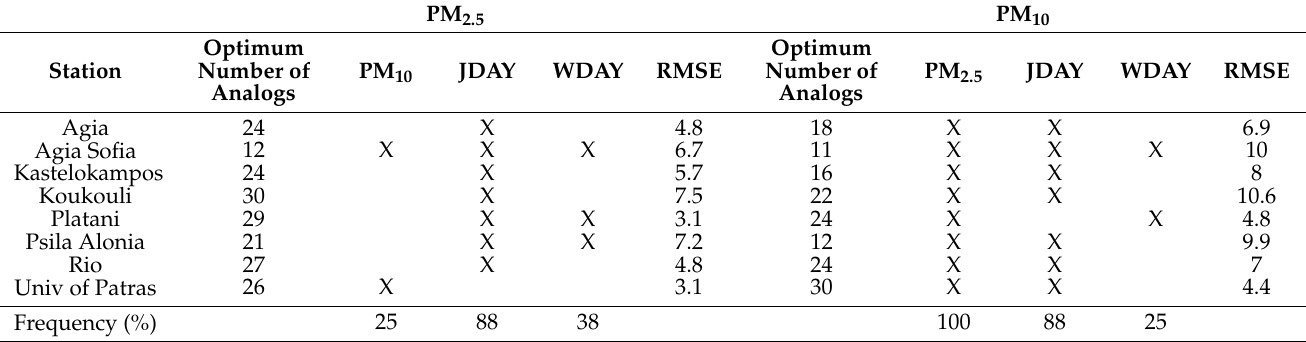
Table 2. The optimum configuration of the analog ensemble at each monitoring site with respect to the number of analogs and the subset of auxiliary variables. PM 2.5 PM